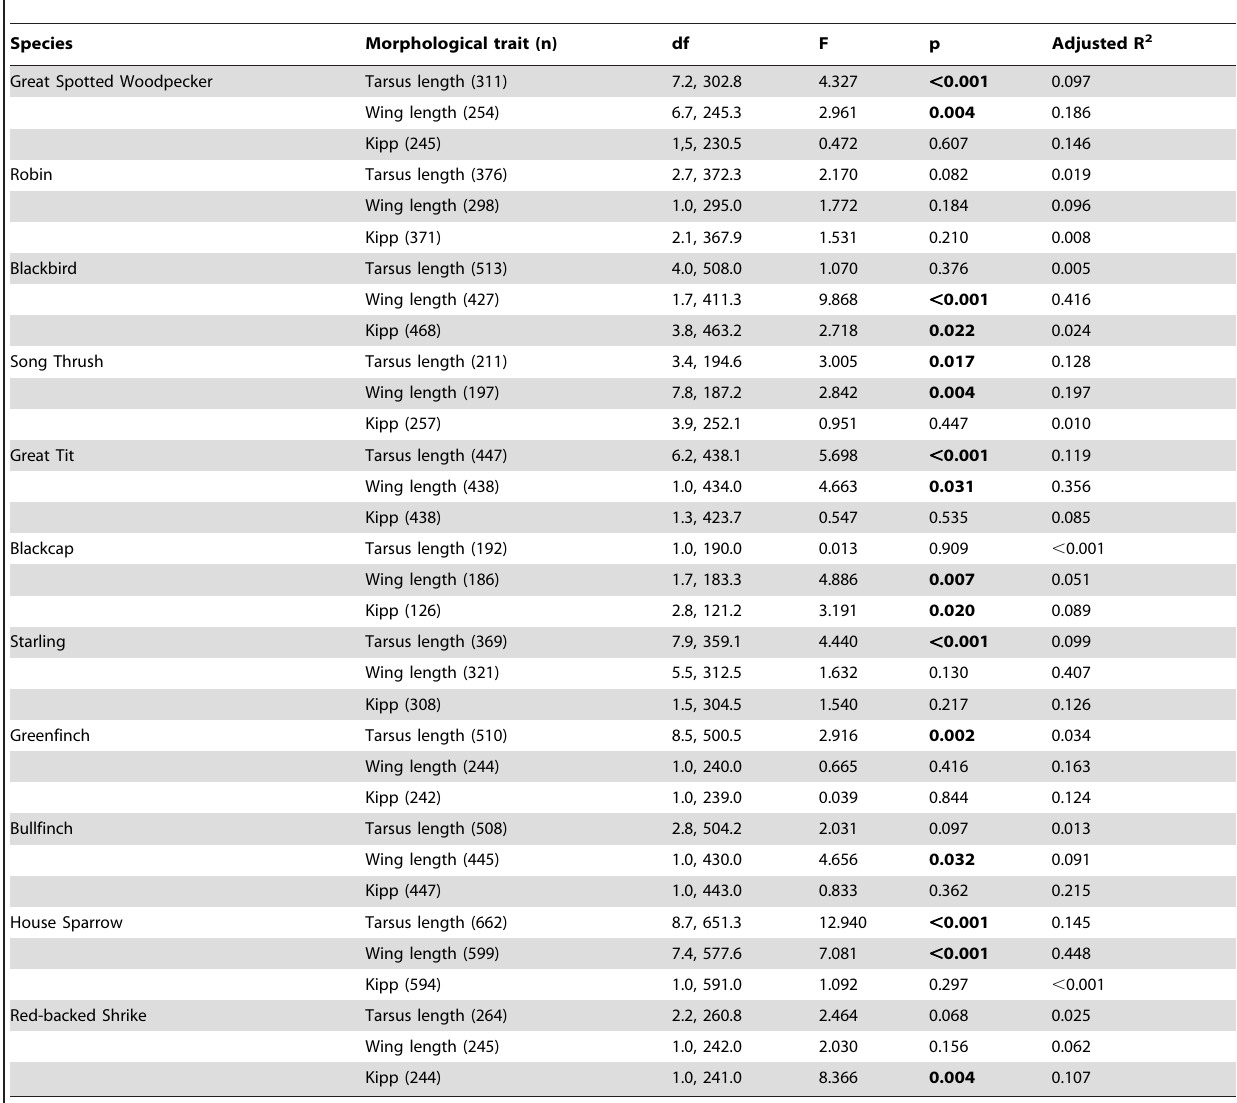
Table 2. Association of three morphological variables for 11 bird species with the smooth term ‘‘year’’ in a GAM.